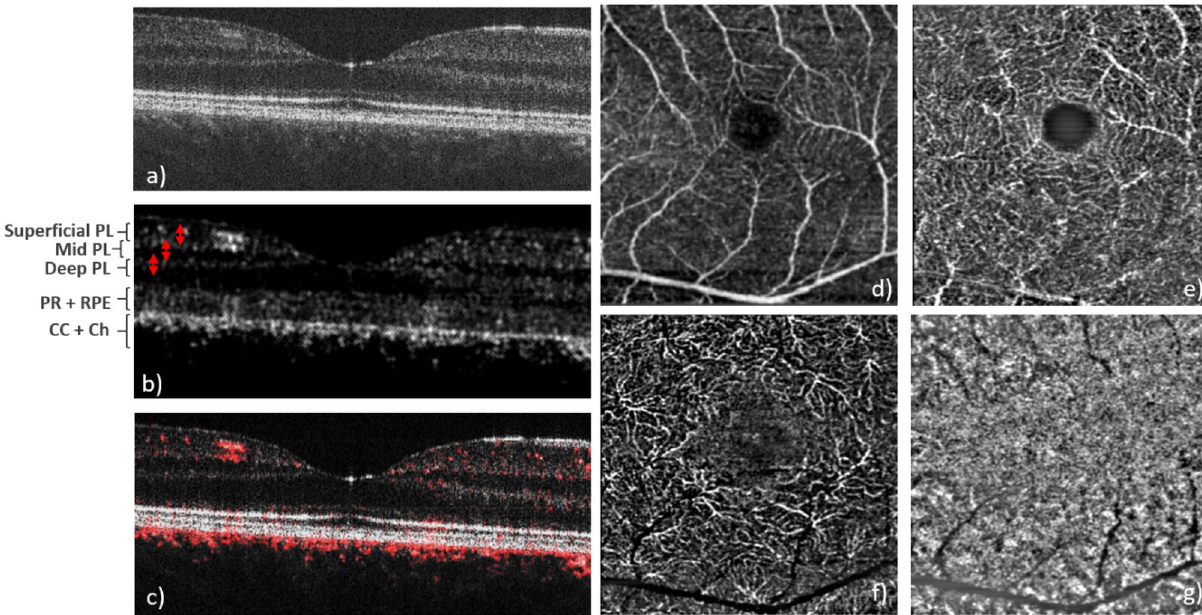
Figure 3. Representative image data recorded with the 10° × 10° field of view scanning pattern and 4 B-scans at the same location. ( a ) Single B-scan intensity image, ( b ) OCTA B-scan, ( c ) composite image of intensity (grey) and OCTA (red), ( d ) superficial vascular plexus, ( e ) mid vascular plexus, ( f ) deep vascular plexus (the integration depth of the en-face projections are indicated with the red arrows in b , g ) choriocapillaris (en-face projection over three pixels below the RPE). PL plexus, PR photoreceptors, RPE retinal pigment epithelium, CC choriocapillaris, Ch choroid.